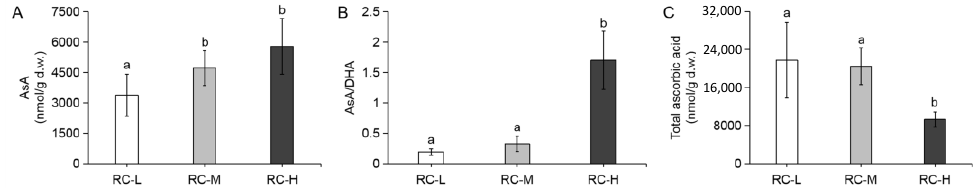
Figure 4 . Contents of ascorbic acid in rhizomes of Rhodiola crenulata (RC-L, RC-M, and RC-H) from different altitudes (3933, 4249 and 4531 m), respectively. ( A ): AsA (ascorbic acid); ( B ): AsA/DHA (ascorbic acid/dehydroascorbate); ( C ): Total ascorbic acid. Results are presented as the mean ± SD of six independent experiments ( n = 6). In each column, different letters (a, b) mean significant difference between two groups ( p < 0.05) found via a t -test. Note: Rhodiola crenulata samples are presented according to the ascending order of altitude from left to right.